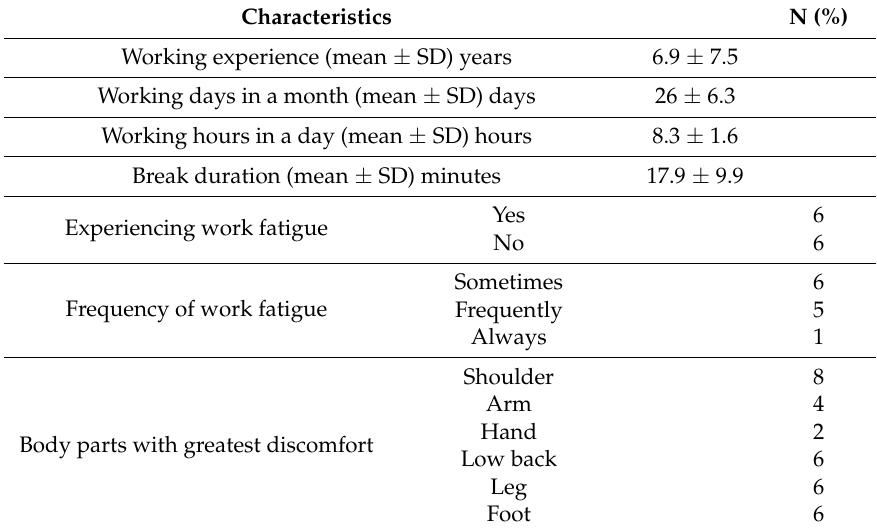
Table 2. Physical ergonomic factors of worker ( n = 12, SD = Standard deviation).